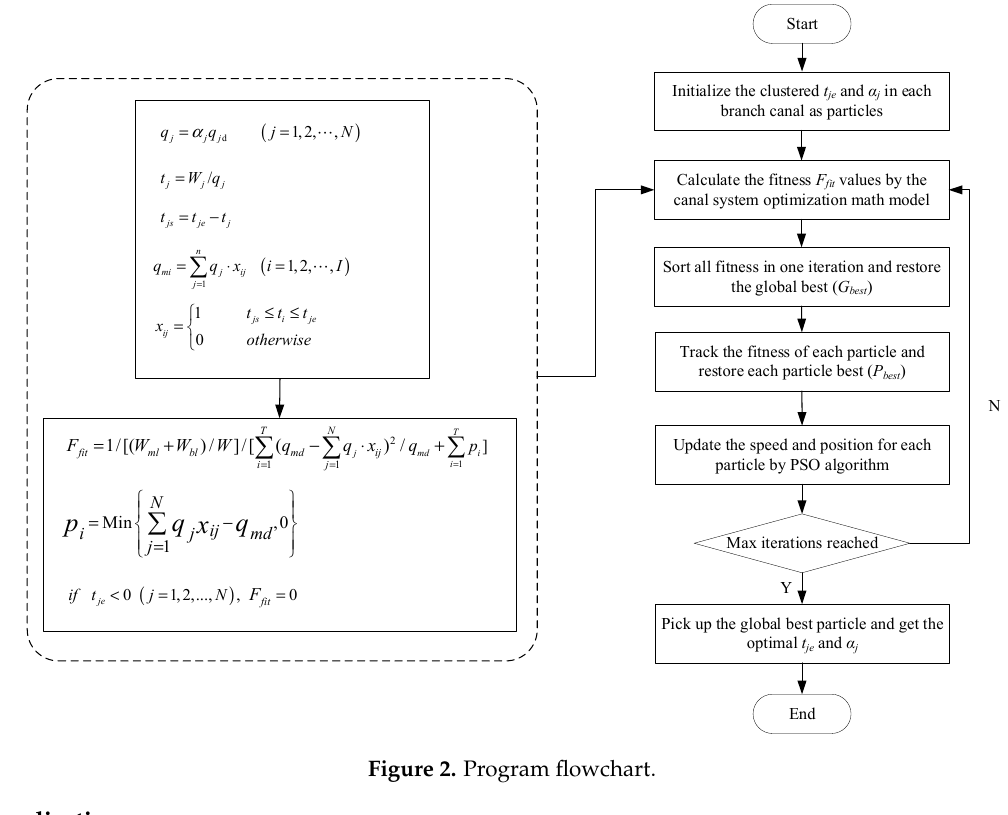
Figure 2. Program Figure 2. Program flowchart.